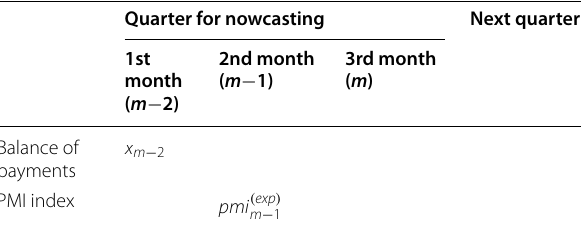
Table 4 Publication of information across time for export of